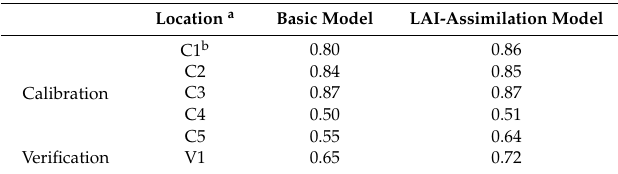
Figure 2. The basic model gave right answers for wrong reasons: ( a ) Reasonably good daily streamflow simulation despite ( b ) a large bias in LAI. The spatial maps correspond to a specific date when MODIS LAI peaked during the 2016 growing season (day 192). To focus on model’s temporal inconsistency, the time series correspond to a specific subbasin where simulated LAI and MODIS LAI showed minimum di ff erence between their respective peak values relative to all other subbasins. Table 2. Evaluation of model performance in daily streamflow simulation. KGE = 1 means 100% agreement between simulated and reference